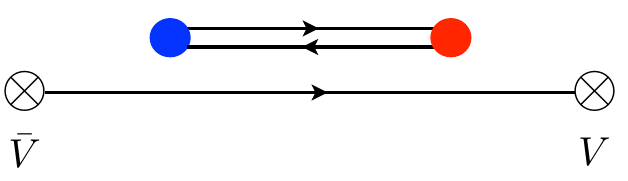
Figure 3 . Meson states are created by double-trace operators and decouple from worldsheet excitations in the planar